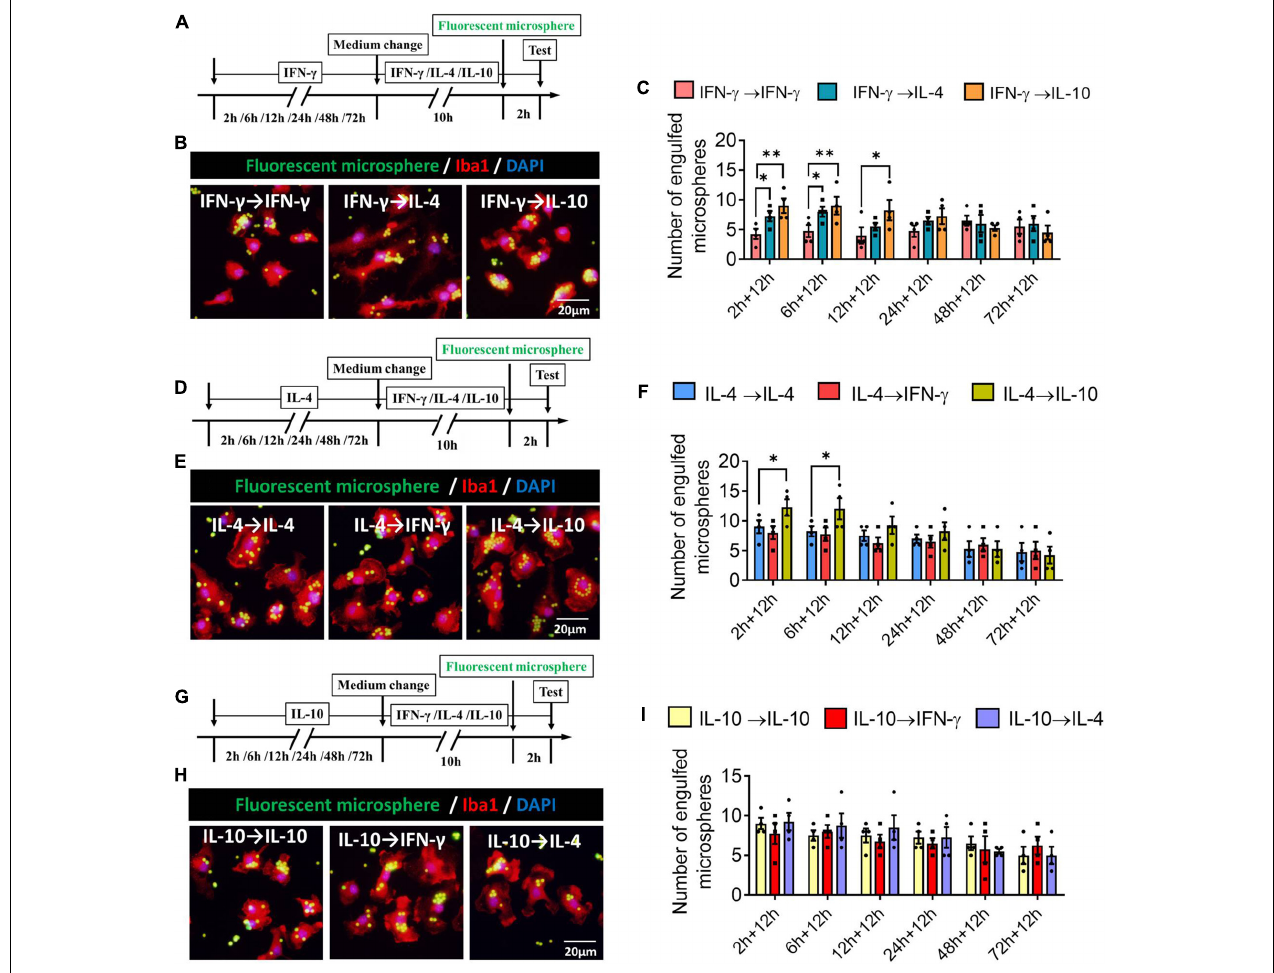
FIGURE 11 | Plasticity of phagocytic ability of IFN- γ , IL- 4-, or IL-10-treated microglia in different response state. (A–C) Plasticity of phagocytic ability of IFN- γ -treated microglia in different response state. (A) Experimental design. IFN- γ -stimulated microglia at different reaction stages following IL-4 or IL-10 exposure for 12 h. Phagocytic activity was measured in the last 2 h. (B) Immunofluorescence imaging was used to examine the phagocytic activity of microglia. (C) Quantification of number of engulfed microsphere by each microglia. (D–F) Plasticity of phagocytic ability of IL-4-treated microglia in different response state following IFN- γ or IL-10 exposure for 12 h. (G–I) Plasticity of phagocytic ability of IL-10-treated microglia in different response state following IFN- γ or IL-4 exposure for 12 h. Five 40 × photographs were taken from each well, and all the cells in the field were measured. Data are presented as the mean ± SEM. n = 4–5 well per group, ∗ P < 0.05, ∗∗ P < 0.01 (one-way ANOVA with Tukey’s multiple-comparisons